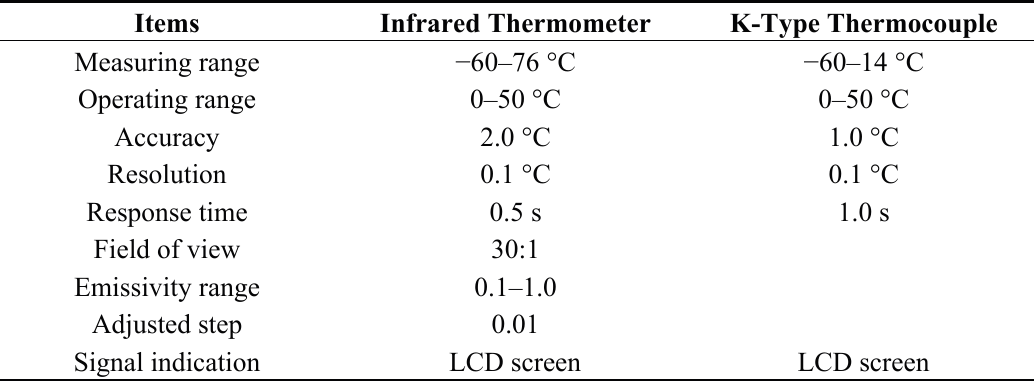
Table1. Specifications of the SI20 LBE infrared